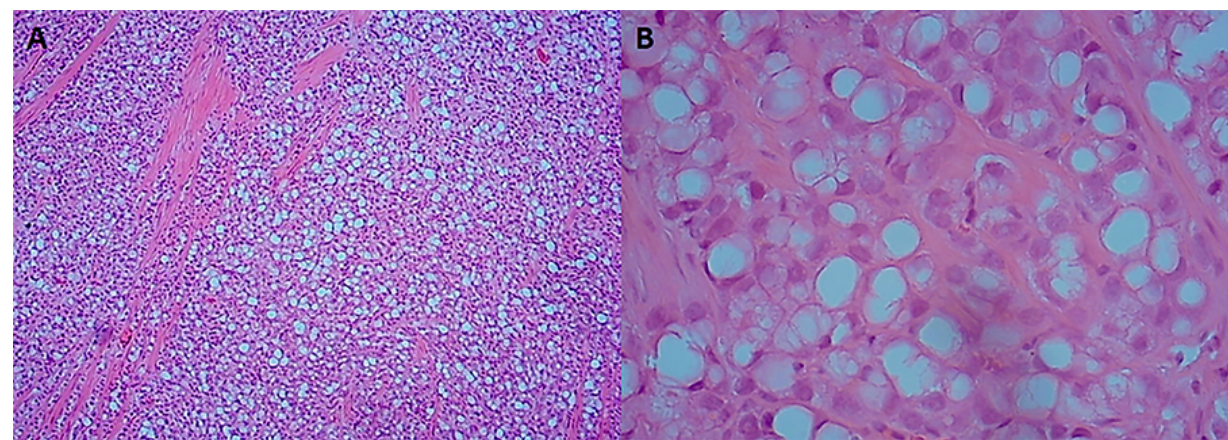
Fig. 1. Diffuse infiltration by signet ring cells is identified (hematoxylin and eosin staining, (A) 40 × , (B) 400 × ).